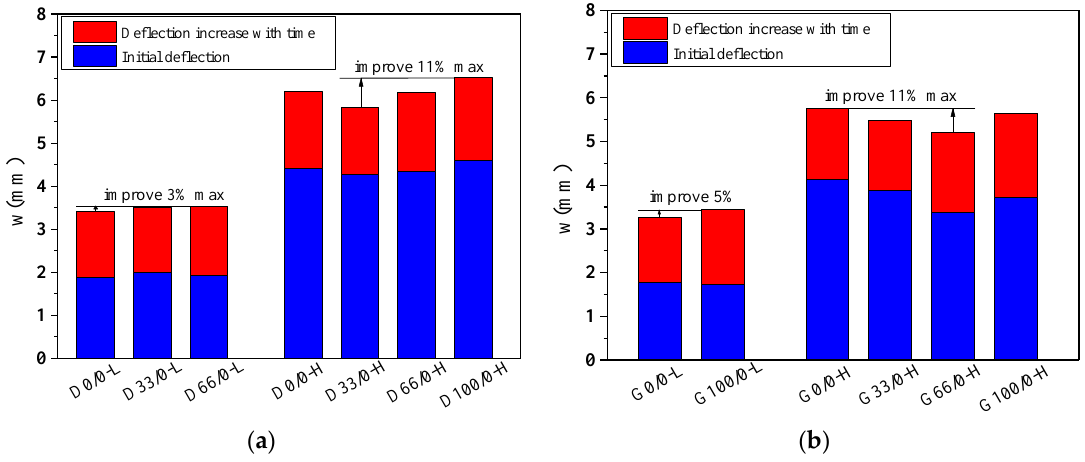
Figure 10. Effect of the RCAs on the ultimate deflection. ( a ) Moderate-strength specimens; ( b ) high-strength specimens.